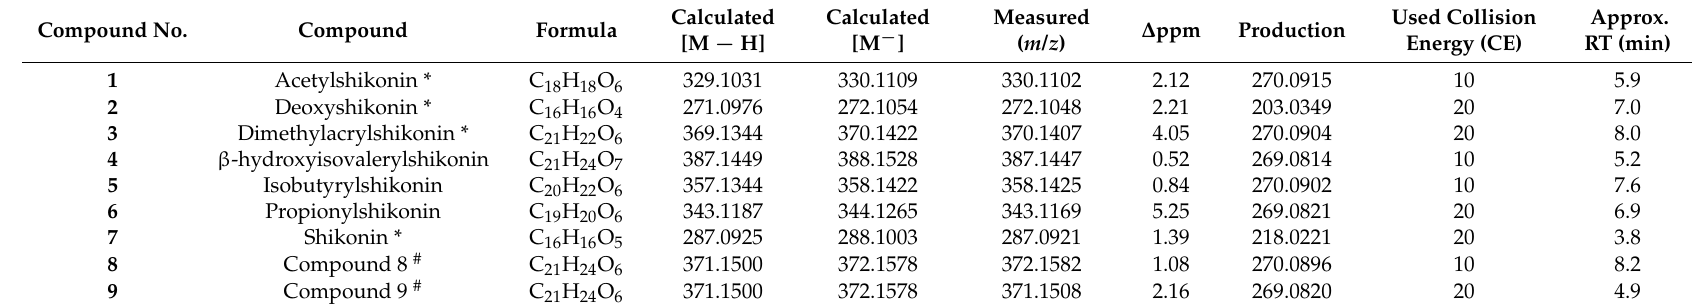
Table 1. Chromatographic and spectrometric properties of shikonins identified/annotated by LC-MS/MS. Compounds were annotated based on m/z of parent and product